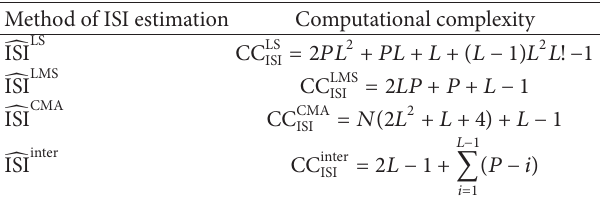
T 1: Computational complexity of ISI